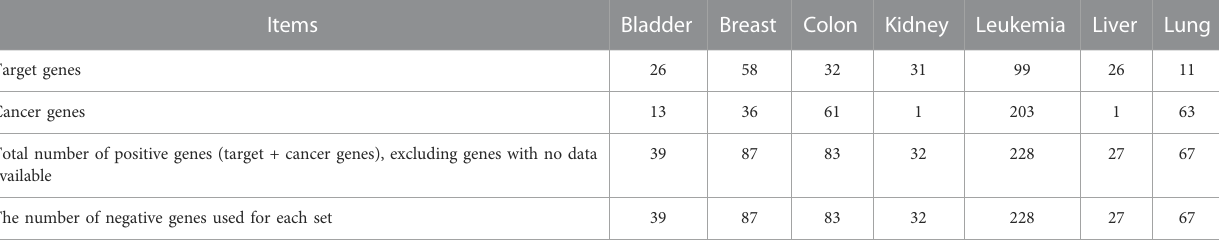
TABLE2StatisticsoftheCancer-Targetbaselinemethods ’ datasets.Itincludesthenumberoftargets,thenumberofcancergenes,andthetotalnumberofpositive and negative genes for each of the seven cancer types. Items Bladder Breast